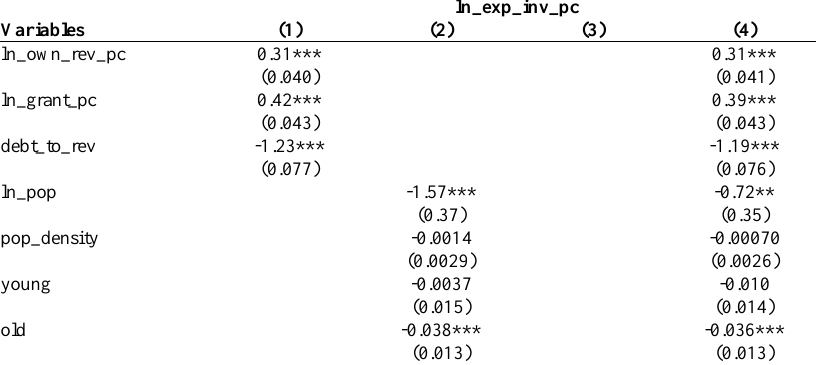
Table 4. Fixed effects (FE) regression results for municipalities with up to 20,000 inhabitants in the years